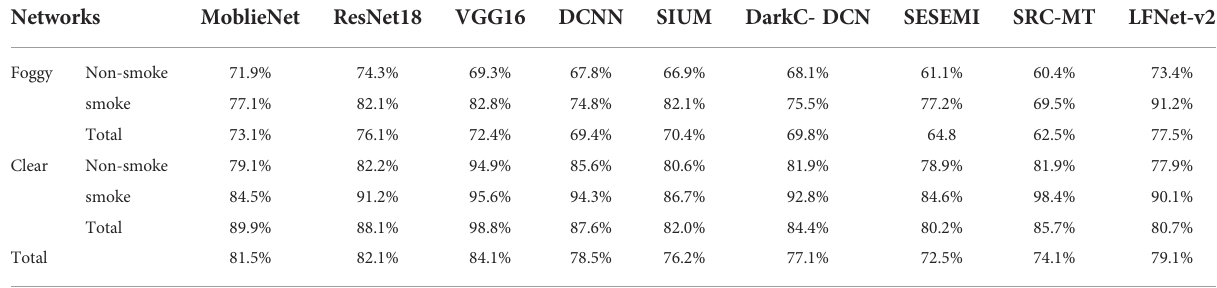
TABLE 2 Comparison of the proposed method with eight state-of-the-art image classi fi cation methods.